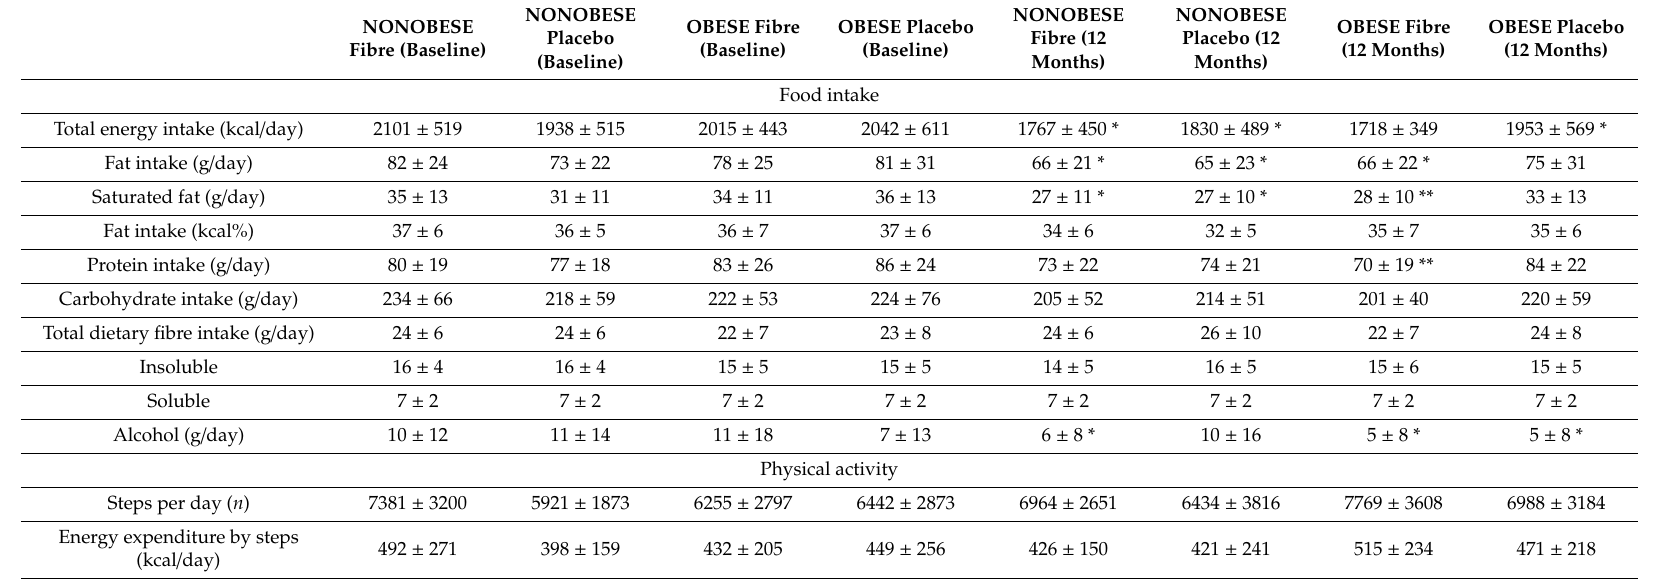
Table 2. Lifestyle habits at baseline and after 1 year of